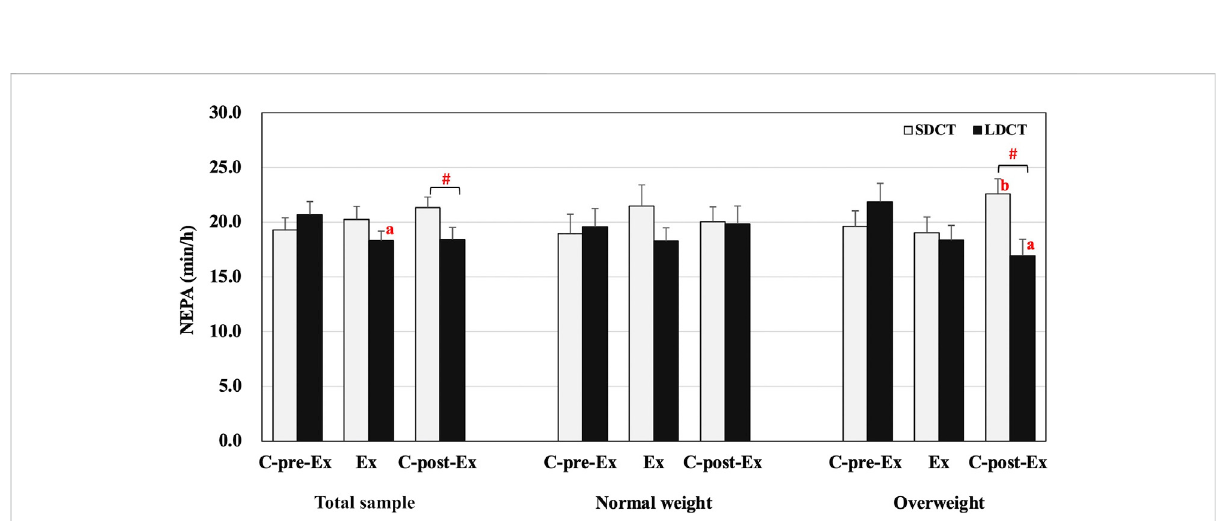
FIGURE 3 Non-exercise physical activity in the total sample, normal, and overweight groups. Data are expressed as the mean ± SEM. # Signi fi cant difference between SDCT and LDCT in the C-post-Ex period, p < 0.05. a Signi fi cantly different from LDCT in C-pre-Ex period, p < 0.05. b Signi fi cantly different from SDCT in the Ex period, p < 0.05. Abbreviations: SEM, standard error of the mean; SDCT, short-duration continuous training; LDCT, long-duration continuous training; C-post-Ex, two-day follow-up period; C-pre-Ex, two-day baseline observation period; Ex, three-day exercise intervention